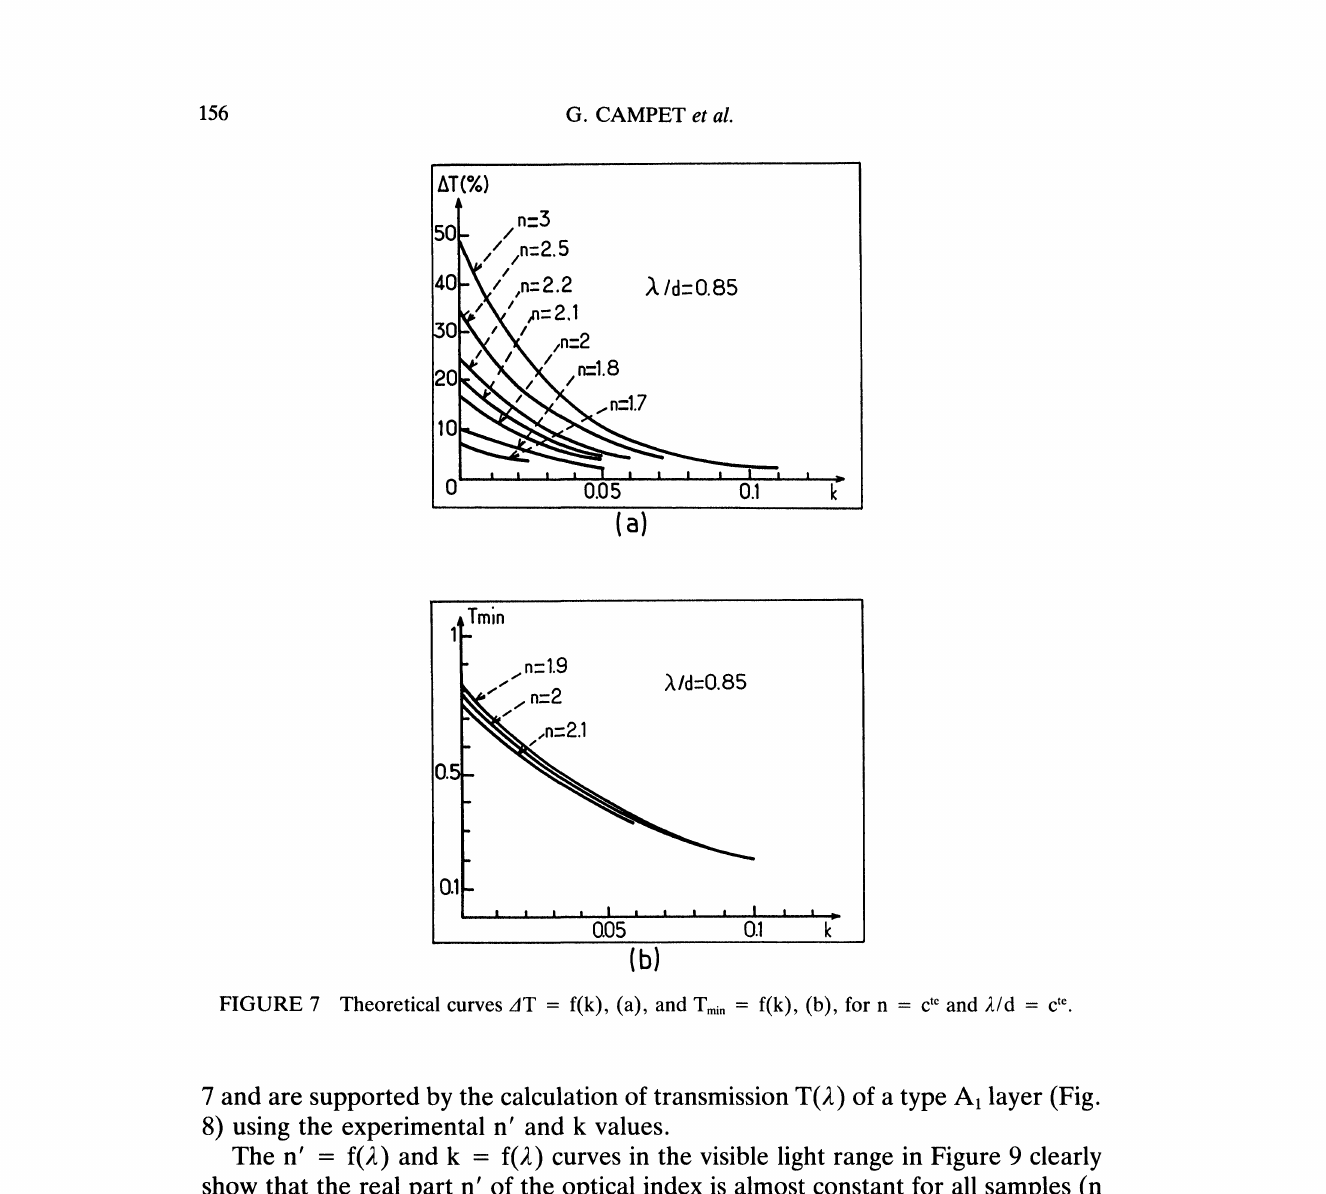
{b} FIGURE 7 Theoretical curves AT f(k), (a), and Tmin f(k), (b), for n c and 2/d c re. 7 and are supported by the calculation of transmission T(2) of a type A1 layer (Fig. 8) using the experimental n’ and k